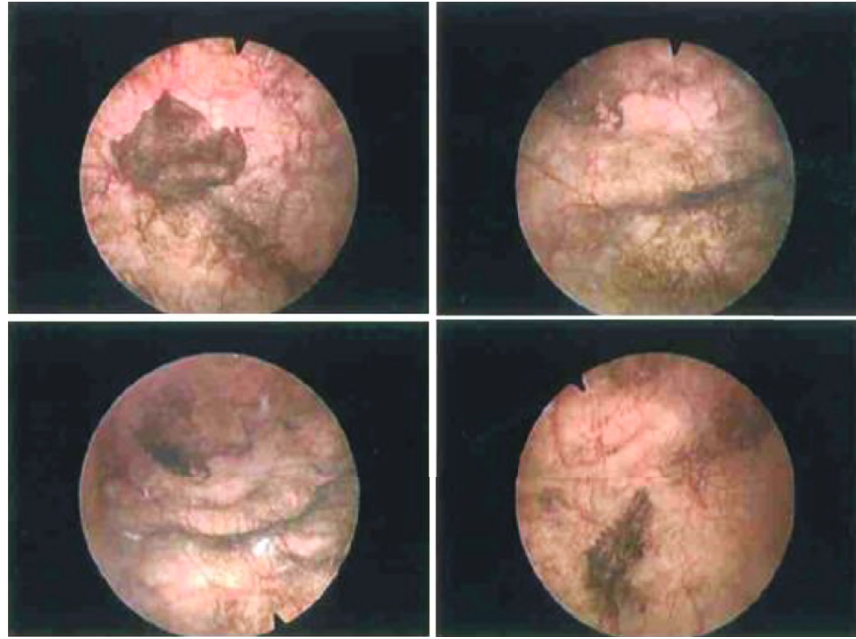
Figure 1: Cystoscopic images showing patches of melanosis of the